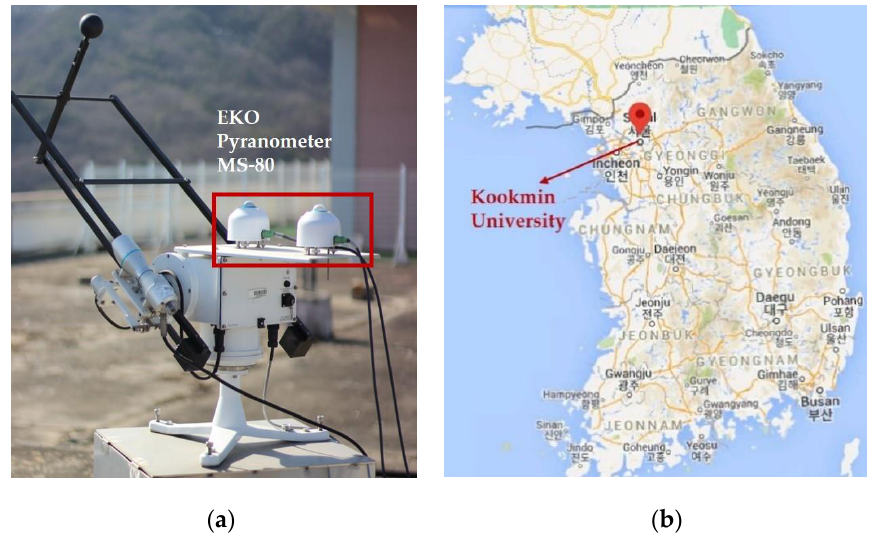
Figure 2. Solar irradiance measurement equipment installed on the rooftop of Kookmin University. ( a ) MS-80 pyranometer to measure the global horizontal irradiance; ( b ) measurement station location.